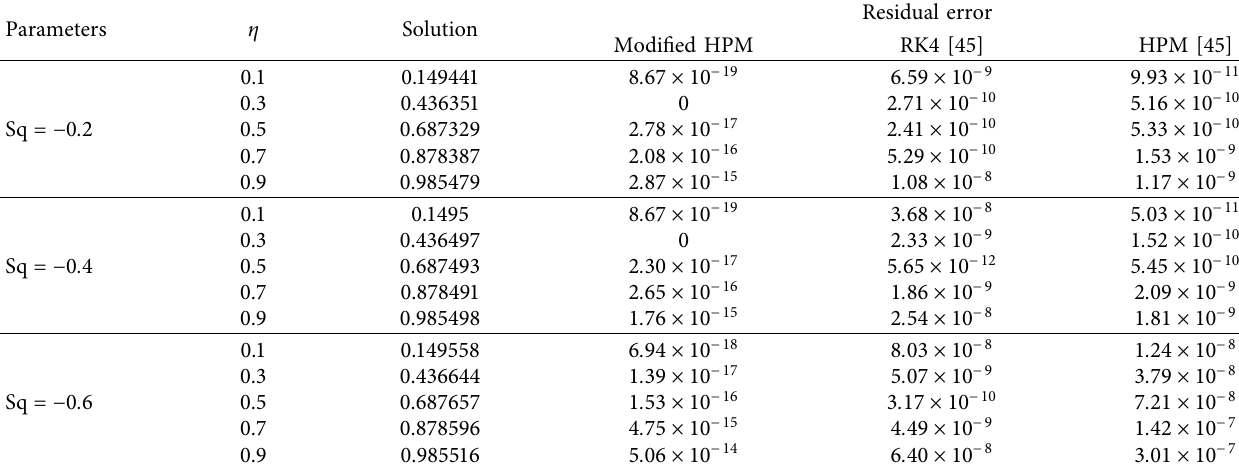
� 0 . 5 � κ � 0 . 05. t t , and β